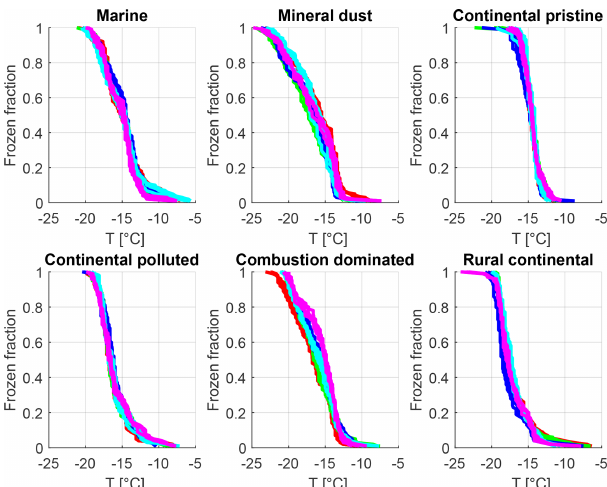
Figure 8. The average freezing temperature of each individual drop (dark blue circles) and the freezing range (from minimum to maxi- mum) for each drop (red error bars), measured during the same con- stant cooling rate experiments depicted in Fig. 6 (minimum of four cooling cycles), for the marine, mineral-dust-influenced, continental pristine, continental-polluted, combustion-dominated and rural con- tinental samples of aerosol material (panels from top left to lower right). All drops displayed also froze during the isothermal experi- ments (up to 10h). The temperature for the isothermal experiments is marked in each panel (dotted cyan line). The median value of the standard deviation for the normal freezing temperature of the indi- vidual drops were in the range between 0.25–0.34K. The median of the temperature ranges (absolute difference between minimum and maximum values) for the freezing temperature of the individual drops were